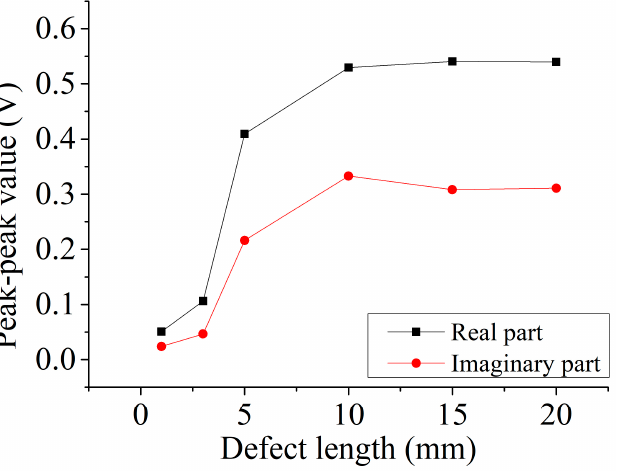
Figure 9. Real and imaginary part output from probe A of different length defects.